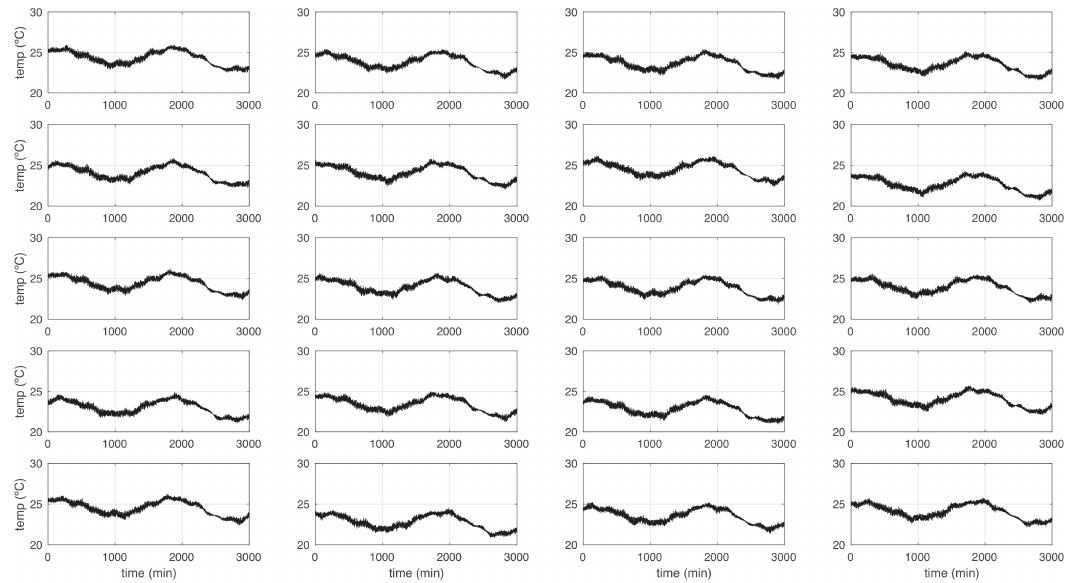
Figure 8. Thumbnails of sensor nodes in a simulated WSN with N = 20.